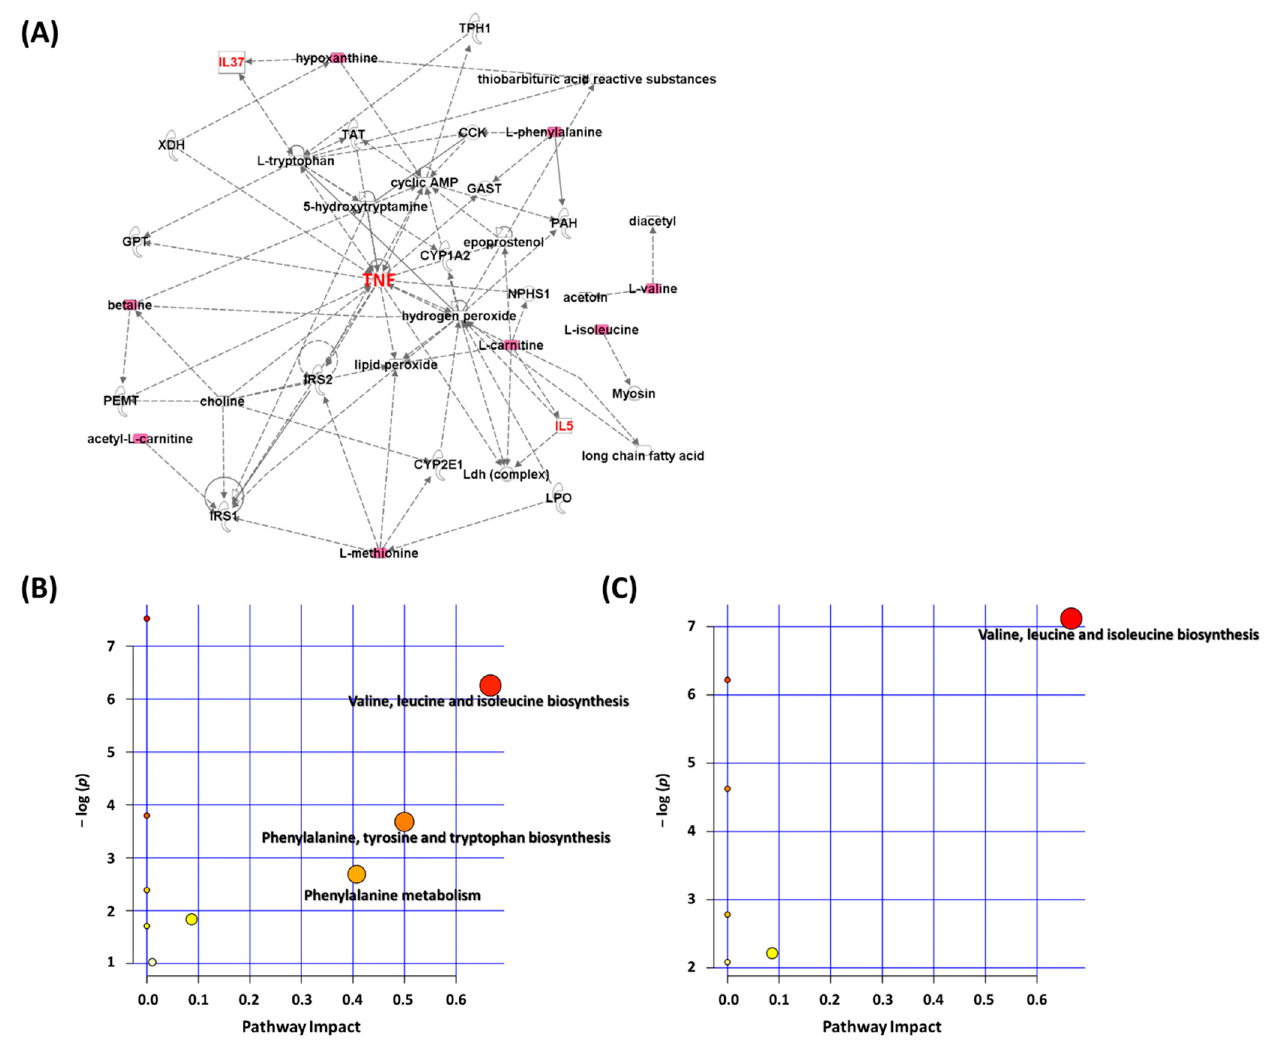
Figure 3. Metabolite signatures analysis of pathways affected by Der p -induced chronic asthma and YGW treatment in mice. ( A ) Network pathways were identified by IPA and MetaboAnalyst software. Molecular network of the Der p group, direct interactions are represented by continuous lines and indirect interactions by dashed lines. The red nodes represent upregulated metabolites and downregulated metabolites by green nodes. Metabolites were inferred in the Der p group from changes in serum levels of intermediates during substance metabolism. Pathways were affected by ( B ) Der p and ( C ) YGW treatment (0.5 g/kg).